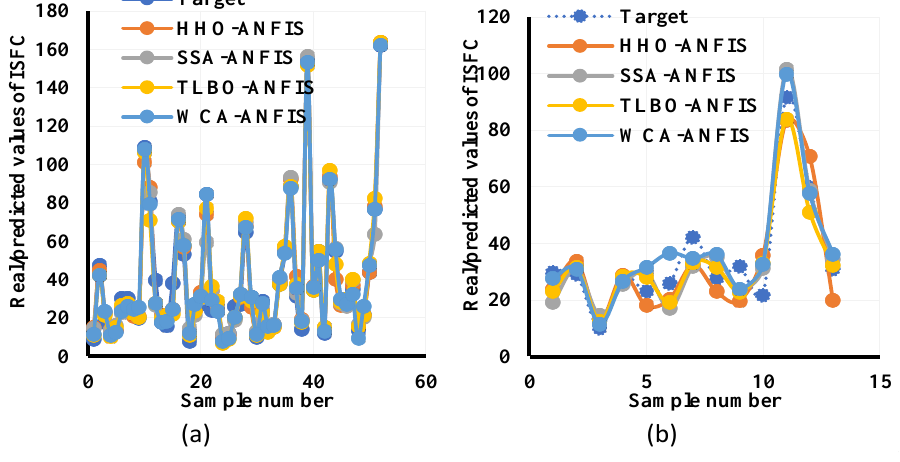
Figure 8. Target ISFC comparison with simulated for ( a ) ISFC training and ( b ) ISFC testing.